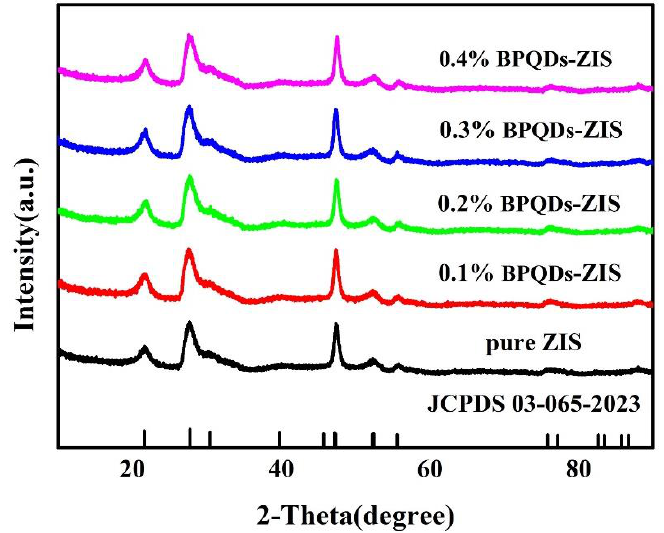
Figure 1. X-ray diffraction (XRD) patterns of pure ZnIn 2 S 4 (ZIS) and black phosphorus quantum dot (BPQD)–ZIS hybrids.